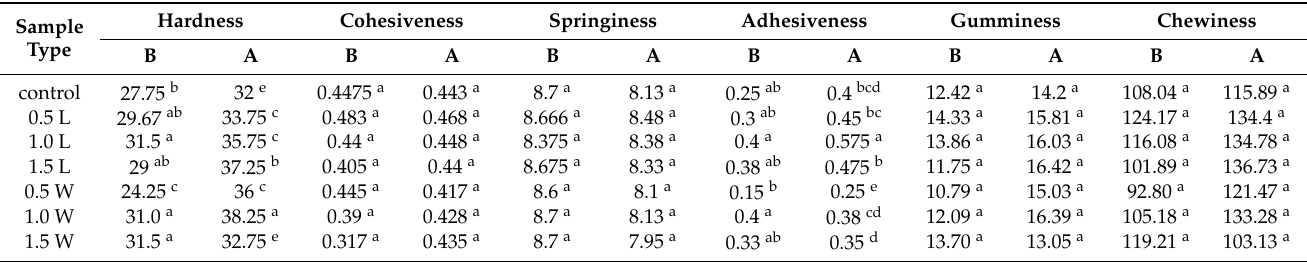
Table 2. Effect of storage period for three weeks at 4 ◦ C on rheological properties of yoghurt.